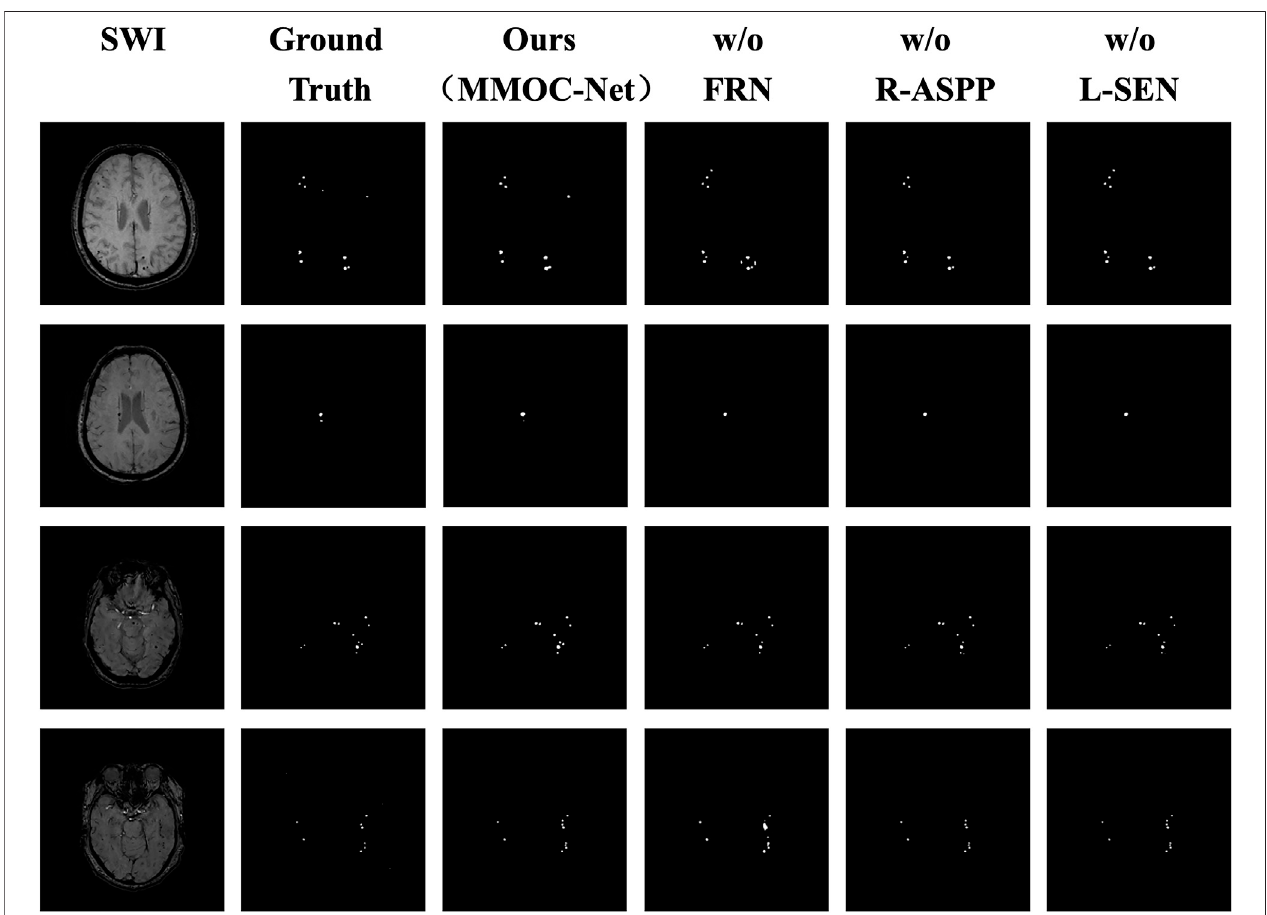
FIGURE 8 | Comparison of the masks of the four ablation combinations. The columns from left to right represent the original image, the ground truth, the MMOC- Net model (ours), w/o FRN, w/o R-ASPP, and w/o L-SEN; the rows from top to bottom represent case Nos. 1 – 4, respectively. In case 1, the lesion in the upper right corneriscorrectlypredictedbyonlyMMOC-Net,whilemisseddiagnosesandmisdiagnoseswereobtainedusingtheotherthreemodels.Incase2,thesmalllesioninthe lower right corner iscorrectlypredicted only by MMOC-Net, while missdiagnosesoccurredusing the other three models. Incase 3, thenumber and distributionof lesions are correctly predicted by MMOC-Net, while miss diagnoses occurred using the other three models. In case 4, MMOC-Net most closely approximates the number and distribution of the ground truth, whereas using the other three models obtain missed diagnoses and misdiagnoses.